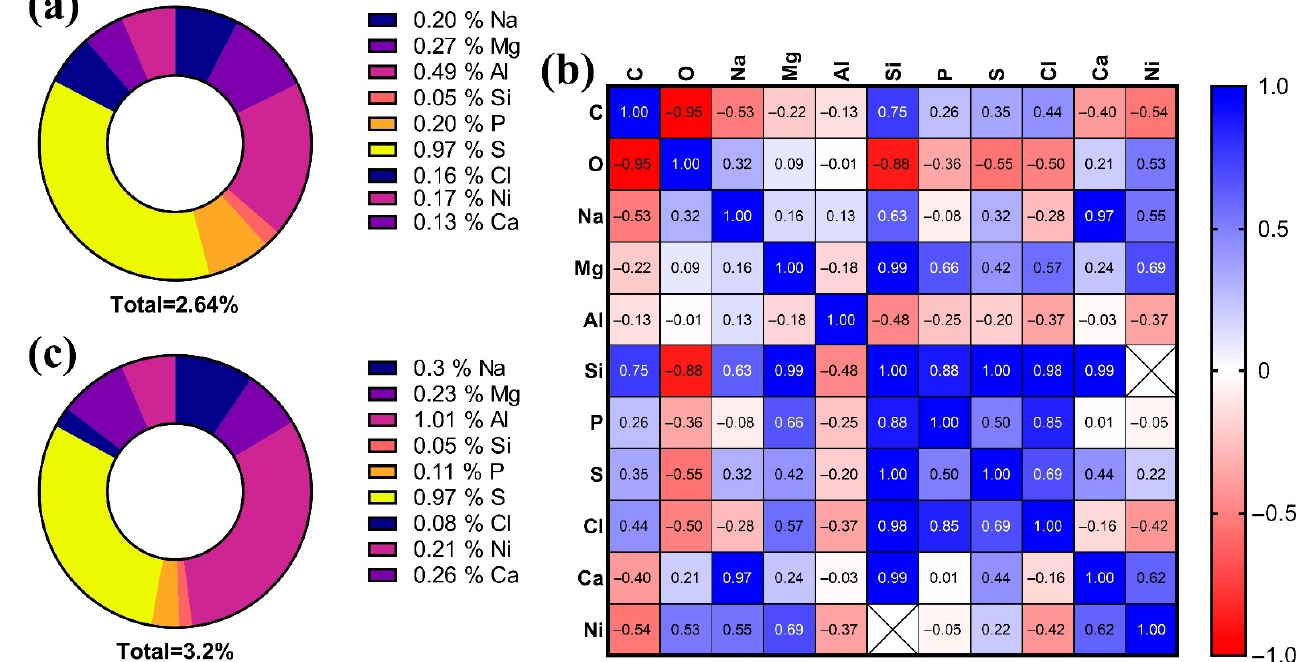
Figure 6. Elemental composition of the lens of N. guentheri : ( a , b ) pie diagrams of the elemental composition of the lens, excluding carbon and oxygen, for individuals two and seven months old, respectively; ( c ) correlation matrix between different elements. Table 1. Elemental composition (weight percent) of the lens of male N. guentheri aged two and seven months.